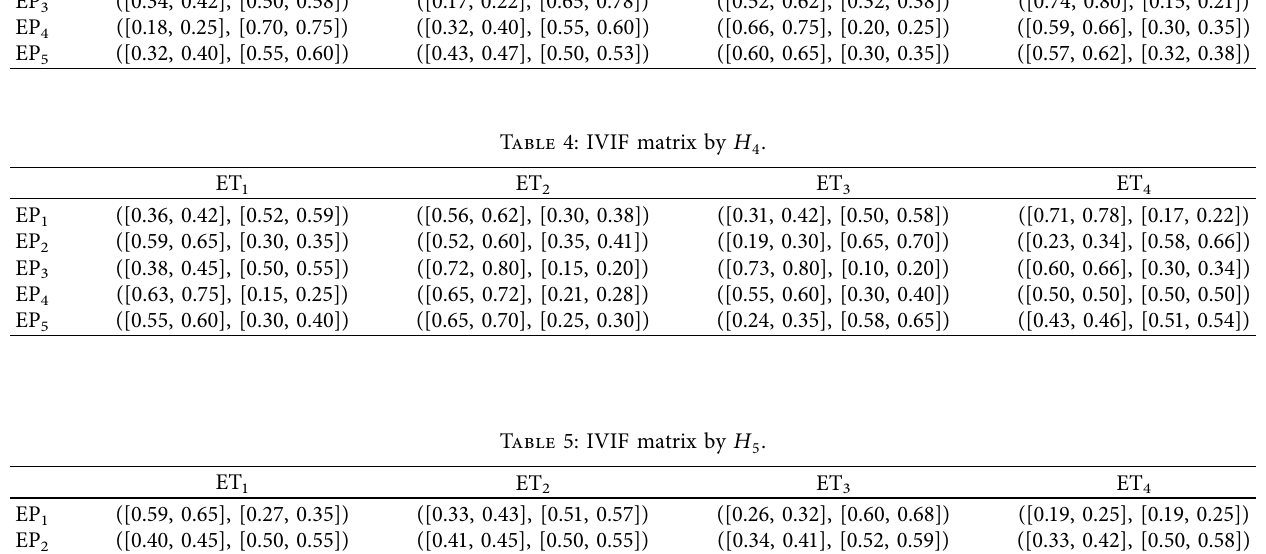
Table 4: IVIF matrix by H